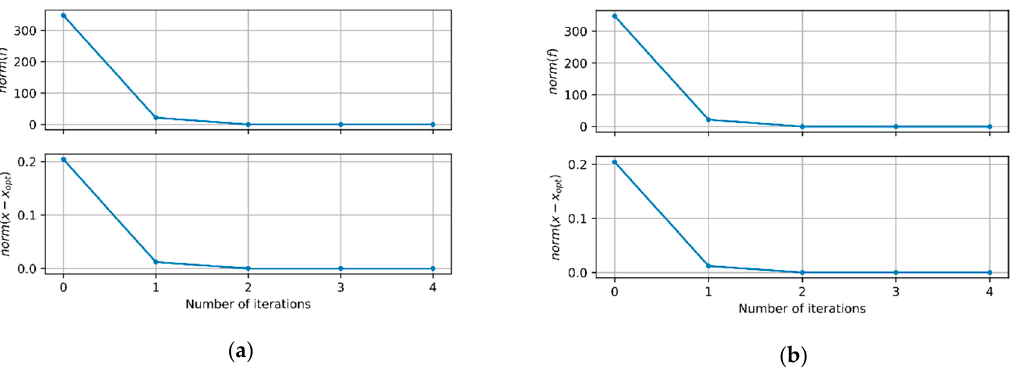
Figure 4. Model updating process ( a ) when the strain was measured and ( b ) when the acceleration was measured.